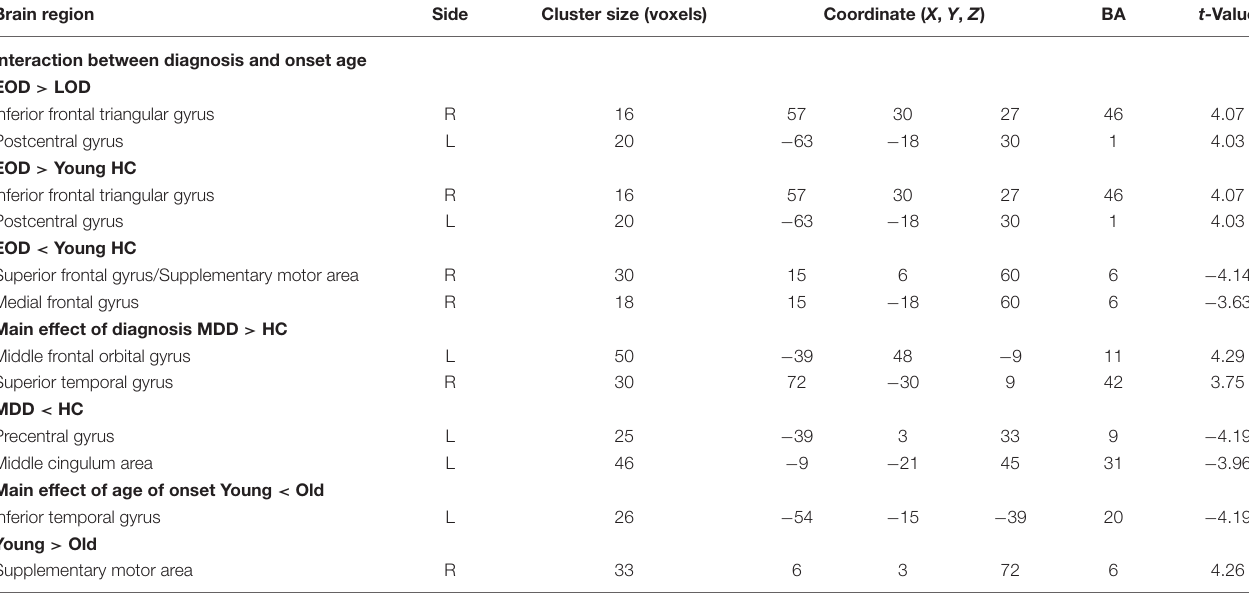
TABLE 2 | Regions showing altered ReHo among the EOD and LOD patients and HCs. Brain region